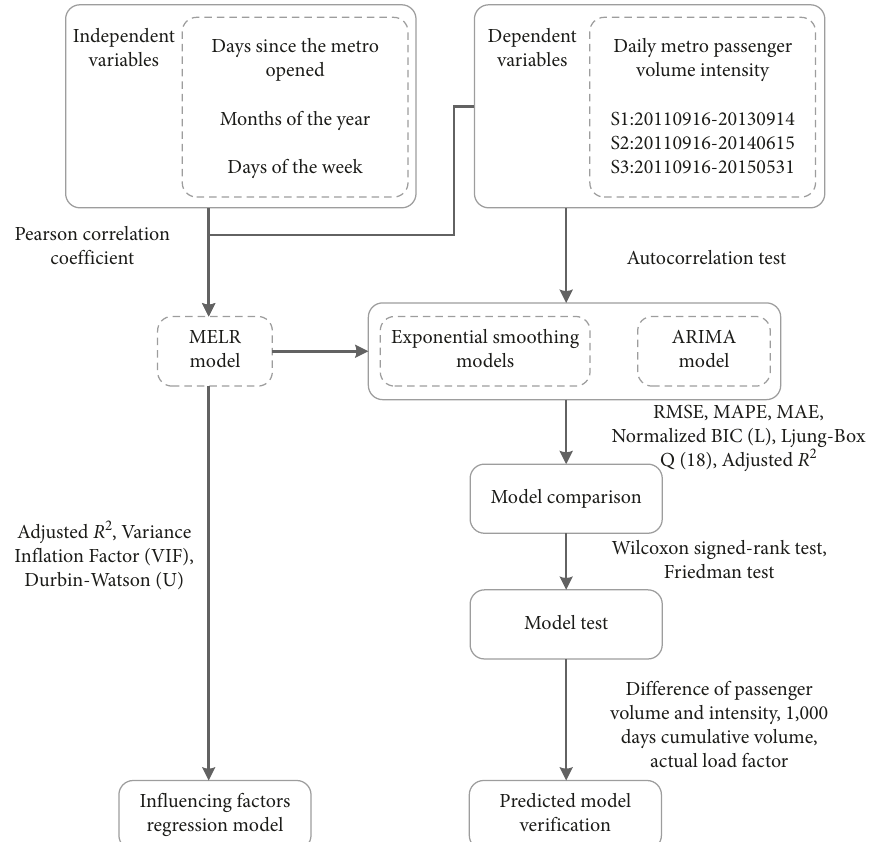
Figure 2: The research